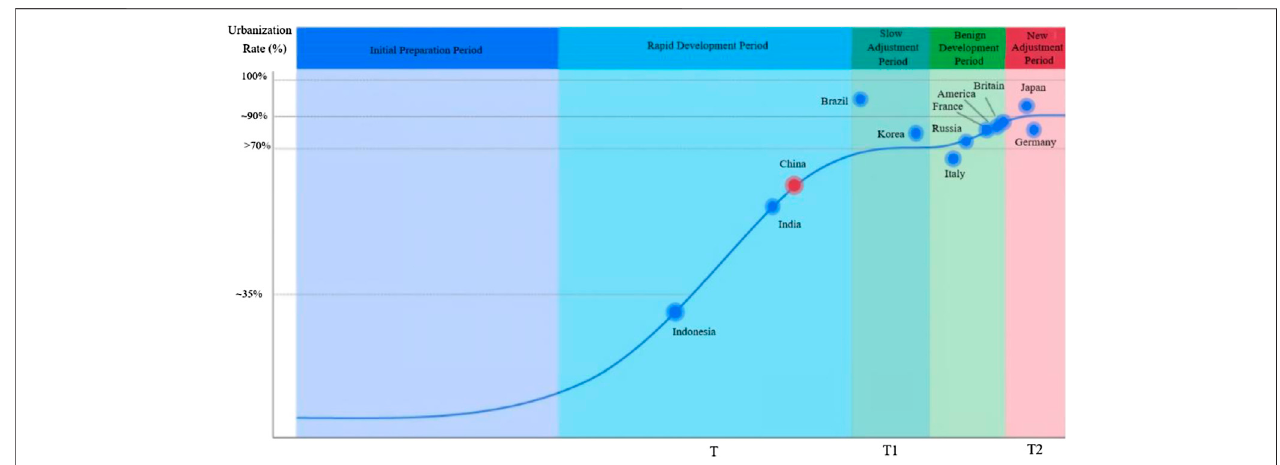
FIGURE1| Thestageofurbanizationinsomecountriesoftheworld.Source:YangXL,2019.DiscussionontheFutureTrendofChina ’ sUrbanization.https://36kr. com/p/5177957. Cited Feb 18, 2019.